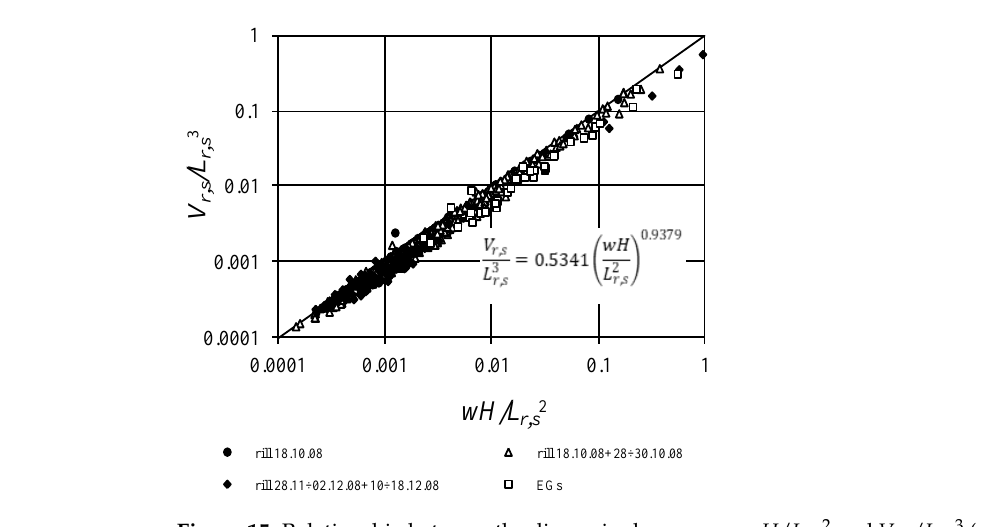
Figure 15. Relationship between the dimensionless groups wH / L r,s 2 and V r,s / L r,s 3 (modified from